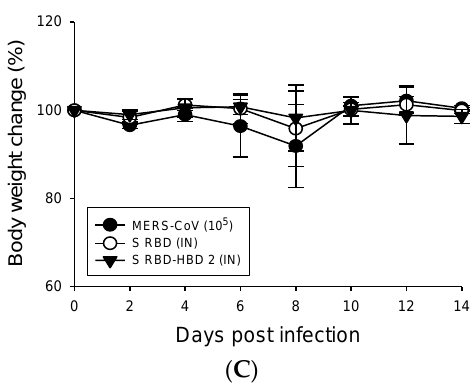
Figure 5. Intranasal administration of S RBD-HBD 2 induces potent systemic antibody responses, preventing MERS-CoV infection in hDPP4-Tg mice. Mice were intranasally (IN) administered with 1 µg/mouse of S RBD with or without HBD 2, and sera were collected three days after the last boost immunization. The serum levels of the S-RBD-specific IgG were measured using ELISA. Data are presented as means ± SDs ( n = 3). Immunized mice were challenged intranasally with MERS-CoV (10 5 PFU). Infected mice were monitored every other day for weight loss, clinical symptoms,